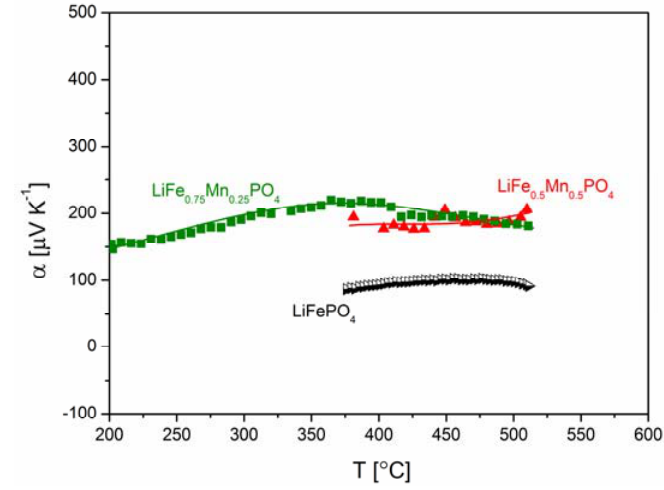
Figure 23. Temperature dependence of thermoelectric power of LiFe